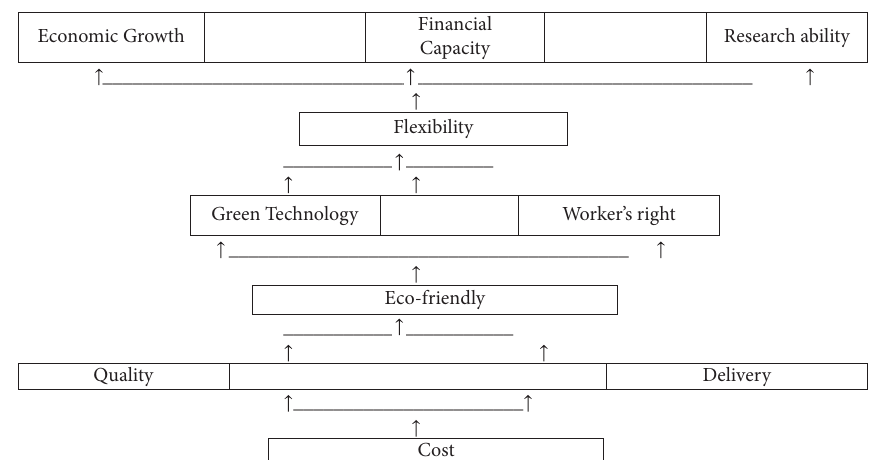
Figure 3: Graphical representation of ISM constructional